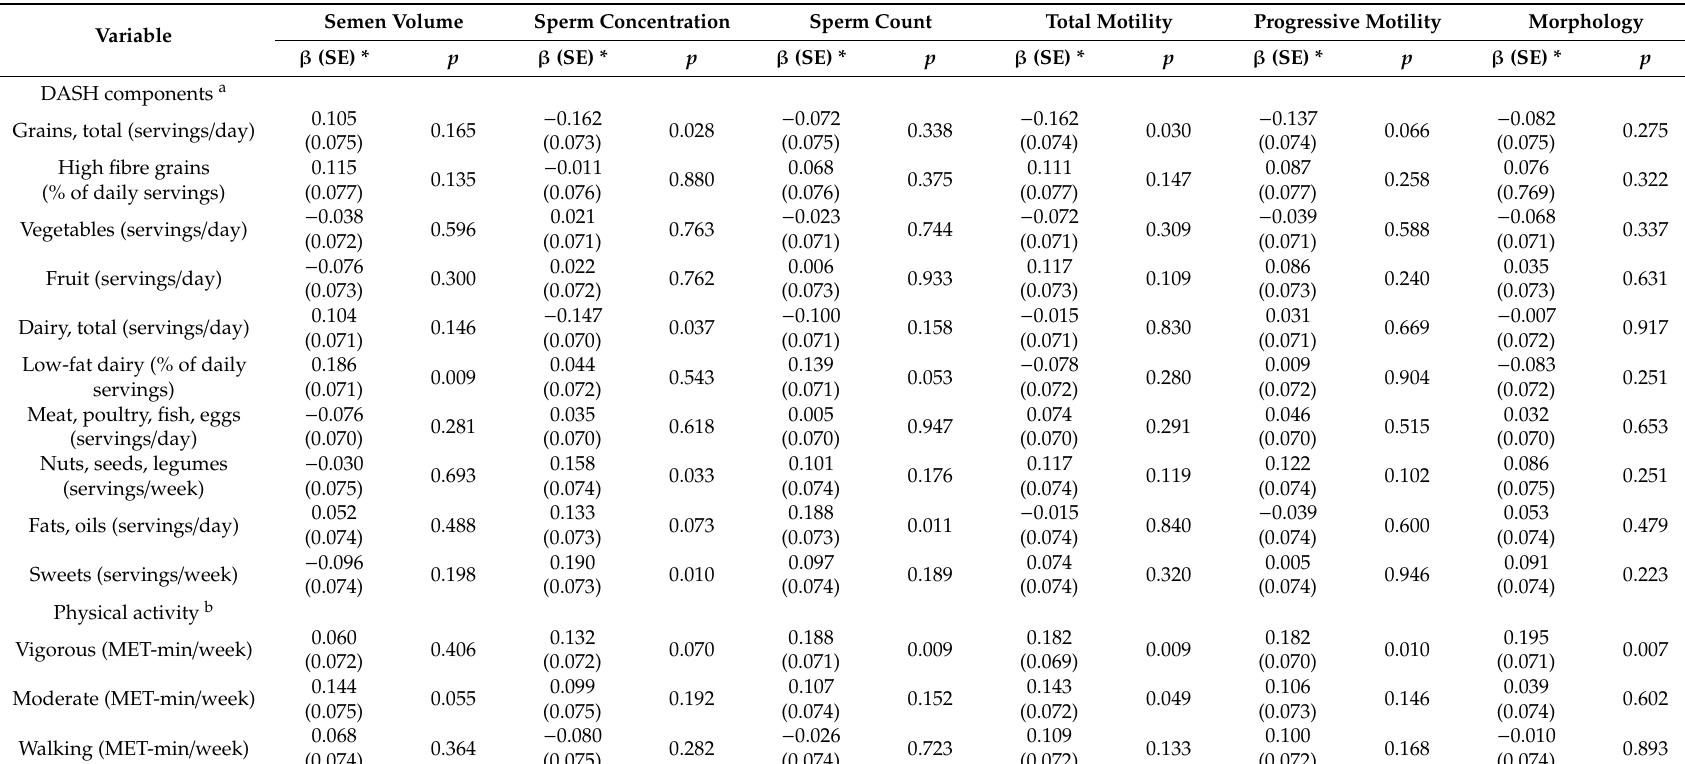
Table 3. Association of semen parameters by individual DASH diet components and physical activity components ( n =